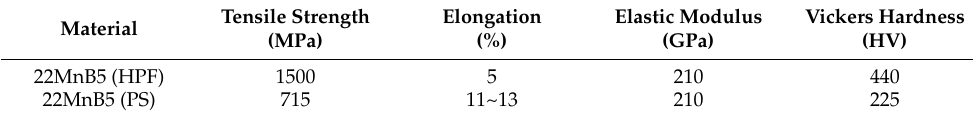
Table 1. Material properties of 22MnB5 (HPF) and 22MnB5 (PS) [20].